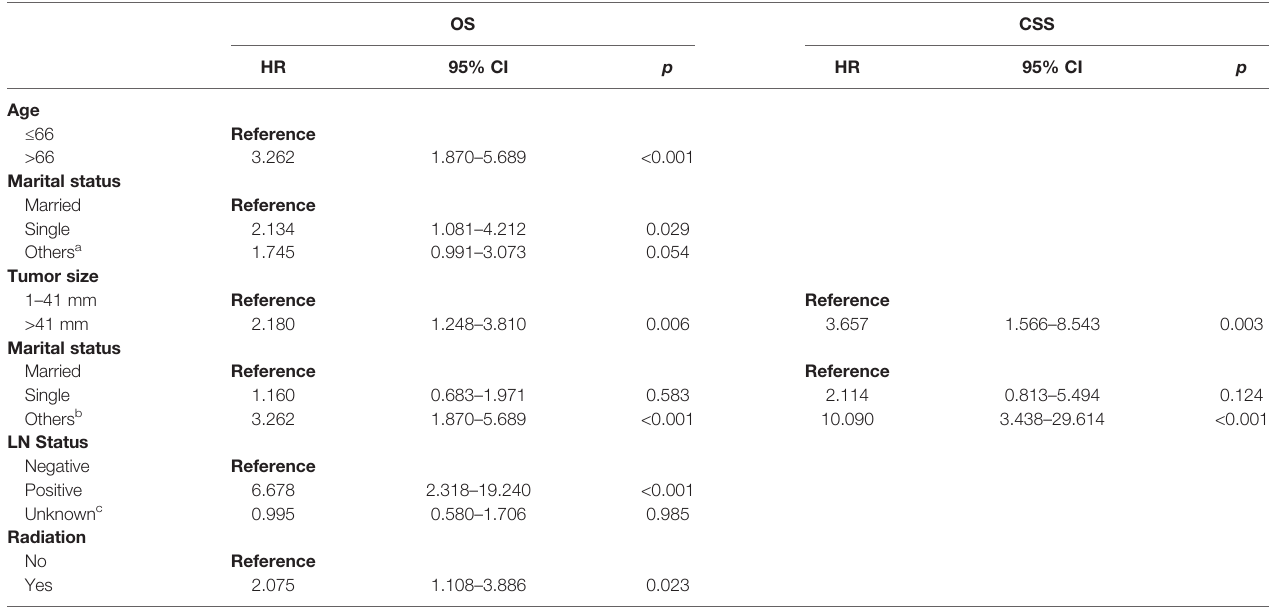
TABLE 3 | Multivariate Cox regression analysis of OS and CSS in patients with parathyroid cancer in the training